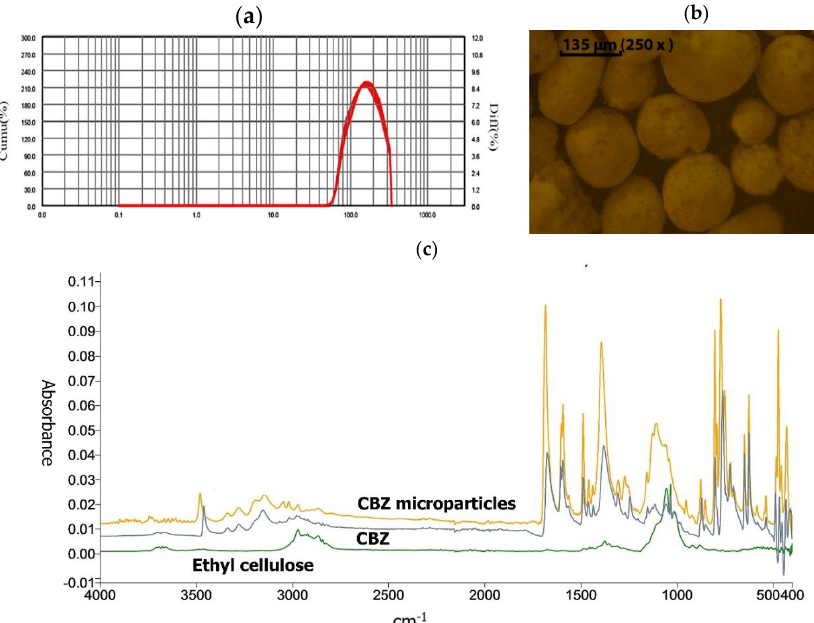
Figure 1. CBZ-loaded microparticle characterization. ( a ) Particle size distribution measured by laser diffraction, ( b ) morphology of the particles under a light microscope, ( c ) ATR-FTIR spectra of ethyl cellulose, CBZ and CBZ-loaded microparticles.